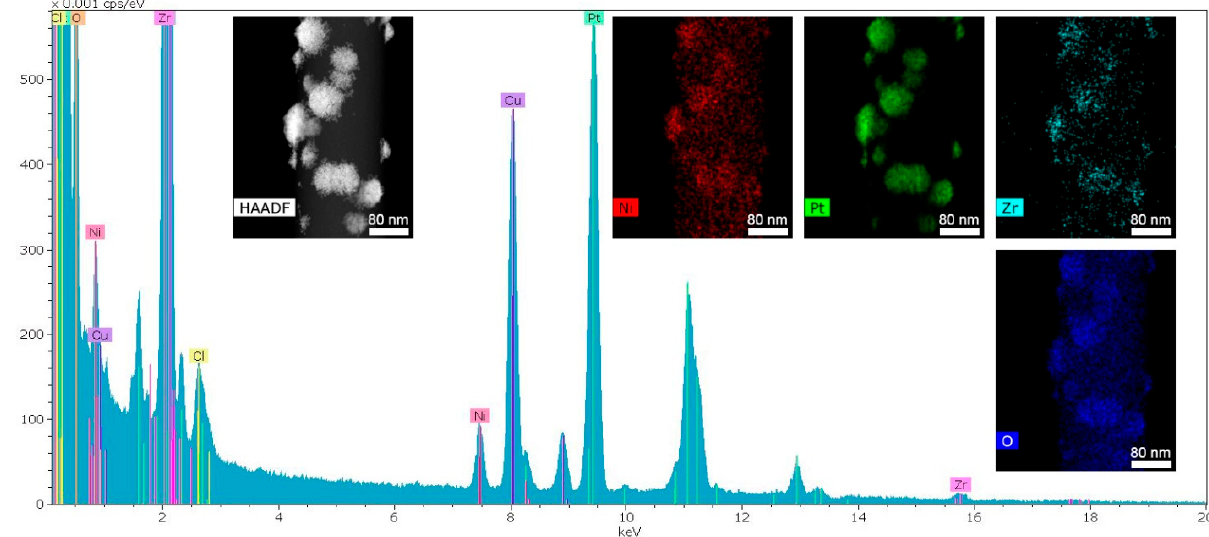
Figure 2. EDX spectrum of a CNF fragment surface (sample 1 ); inserts: STEM HAADF image and corresponding elemental maps.